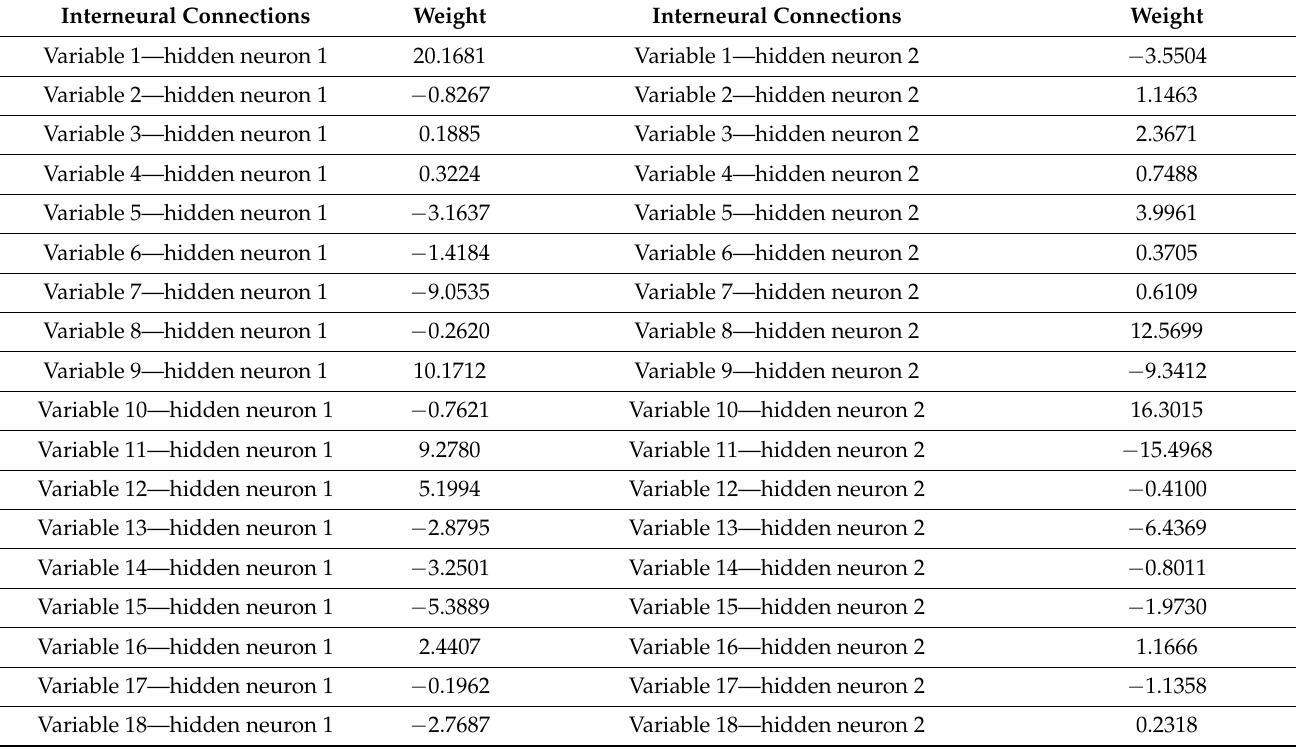
Table 2. Set of interneural weights of network MLP 18-3-1.